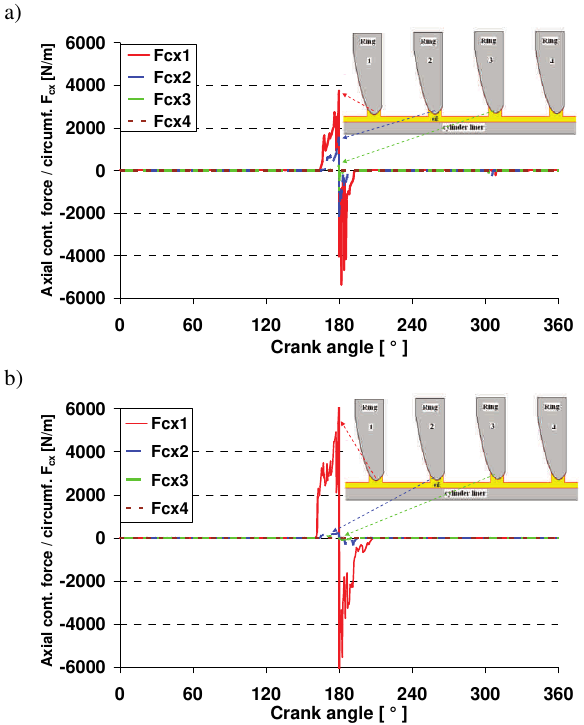
Fig. 8. Variation in tangential component of contact force F cx_i for each piston ring (i – ring number) versus crank angle. Piston ring pack configu- ration: a) 4xSC, b) GT+3xSC